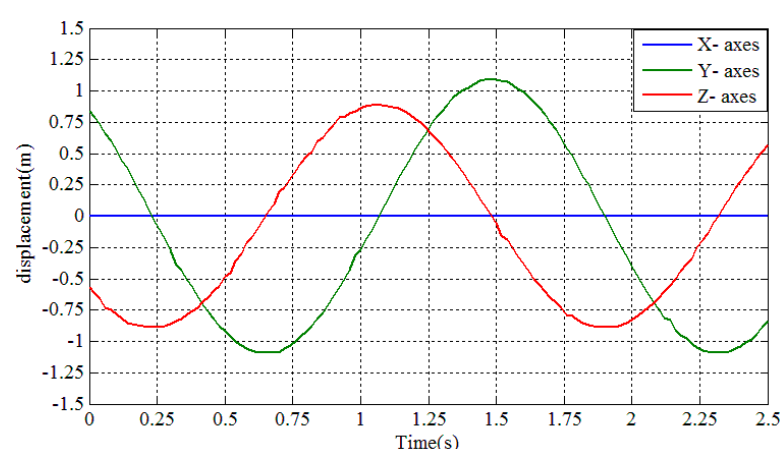
Figure15. Collected data of the accuracy test.